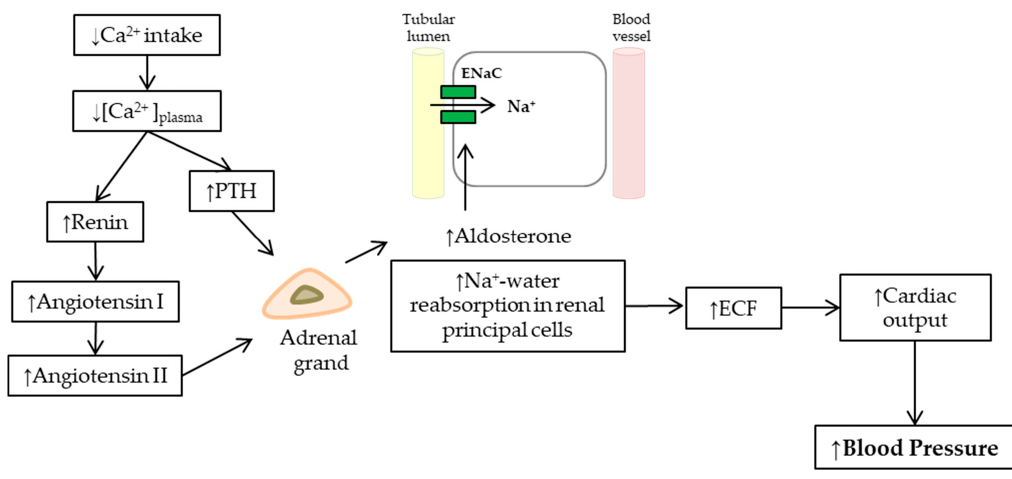
Figure 2. Scheme of the mechanisms involved in the rise of blood pressure in low calcium intake via